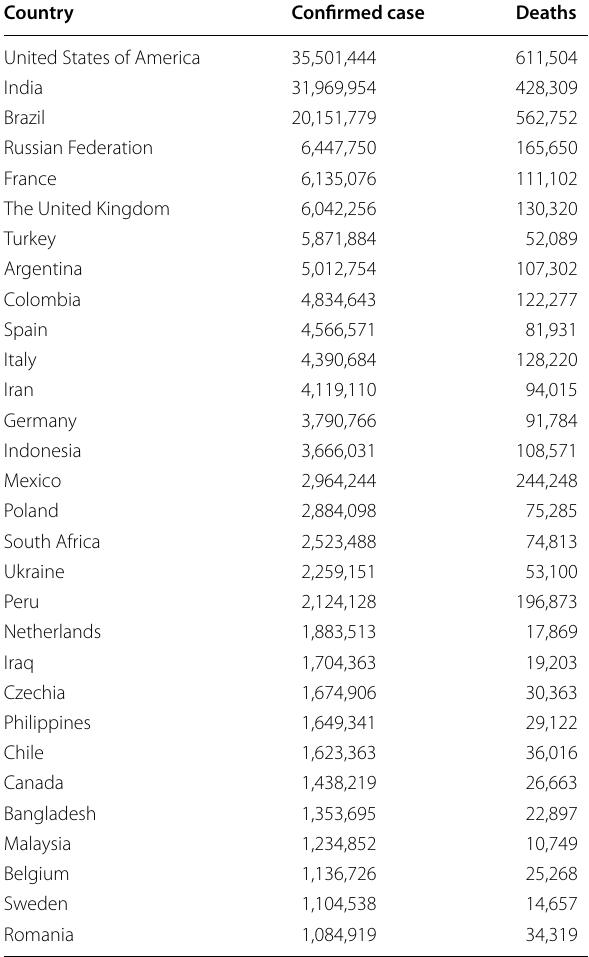
Table 1 Data on the number of confirmed cases and death